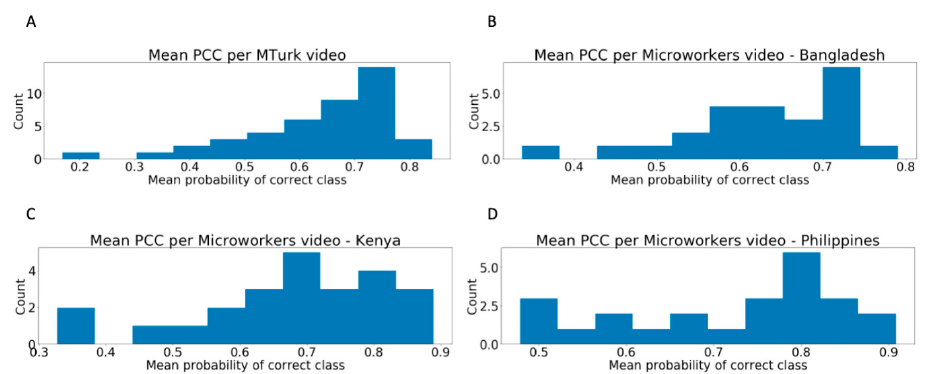
Figure 2. Distribution of average classifier probability of the correct class per video with at least ten ratings from ( A ) MTurk workers, ( B ) Bangladesh Microworkers, ( C ) Kenya Microworkers, and ( D ) Philippines Microworkers. There is wide variability in the difficulty level of rated videos.